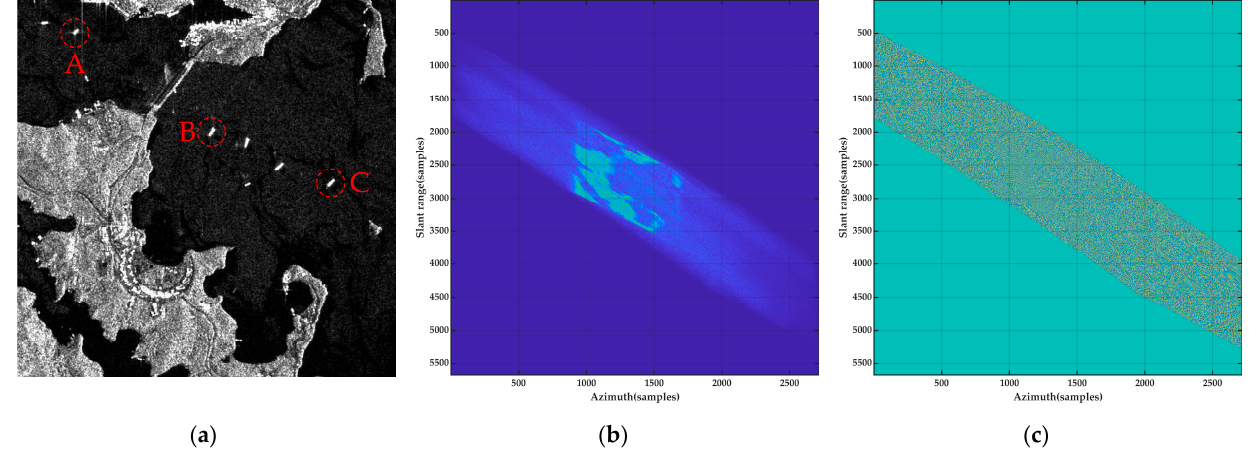
Figure 13. The natural ocean scene and its echo signal generated by the TBT algorithm for the GEO-